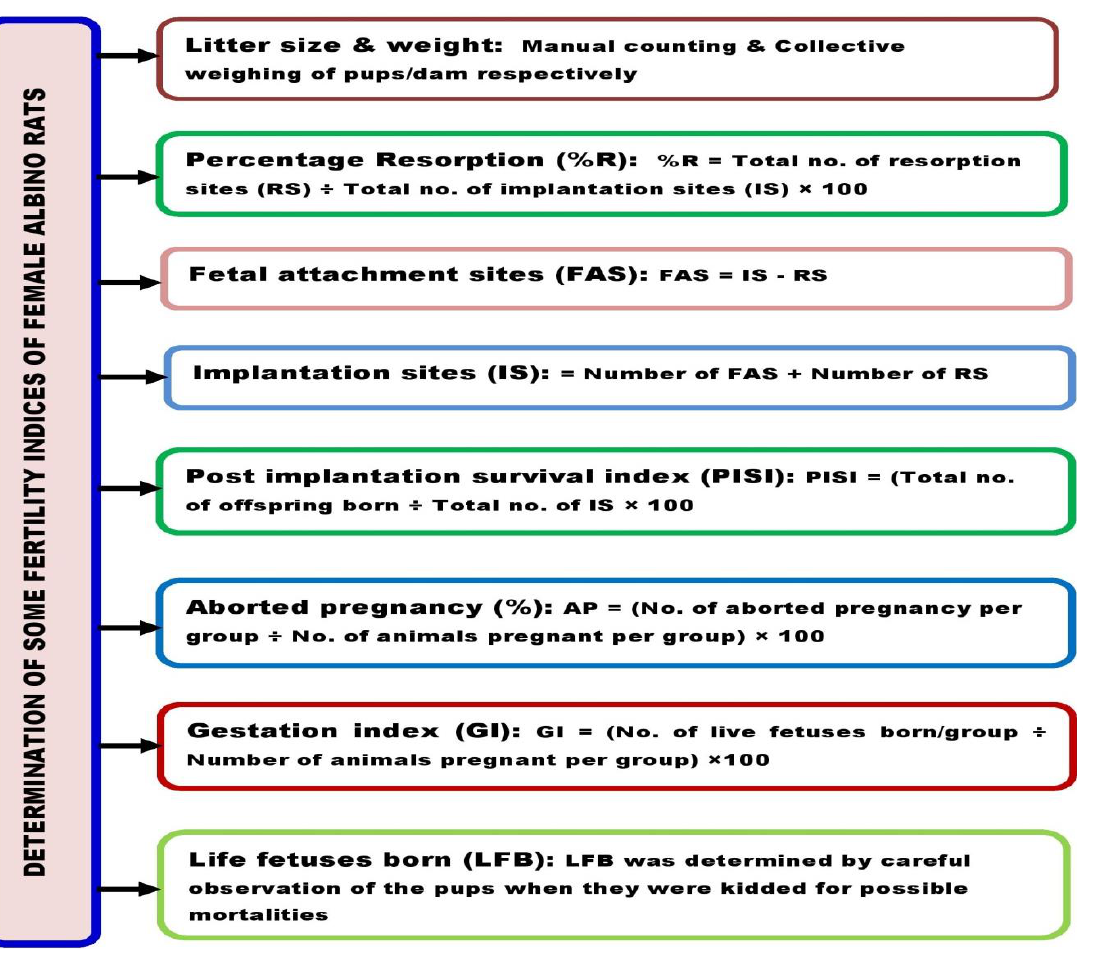
Figure 3. A schematic representation of various fertility indices determined in the MSEAI-treated female rats and the description of various methods used during the determination.